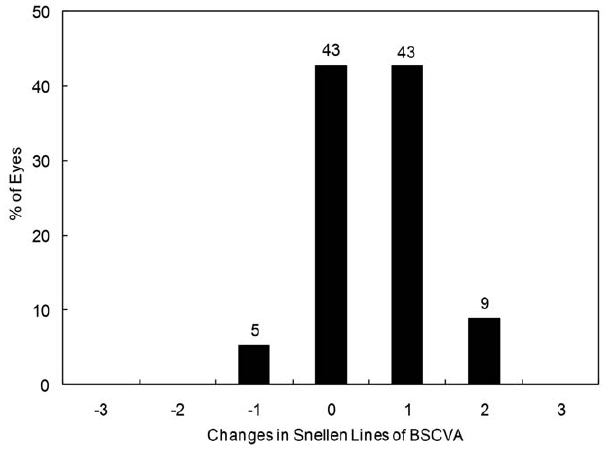
Figure 2. Changes in uncorrected visual acuity (UCVA) after toric implantable collamer lens implantation. UCVA=uncor- rected visual acuity